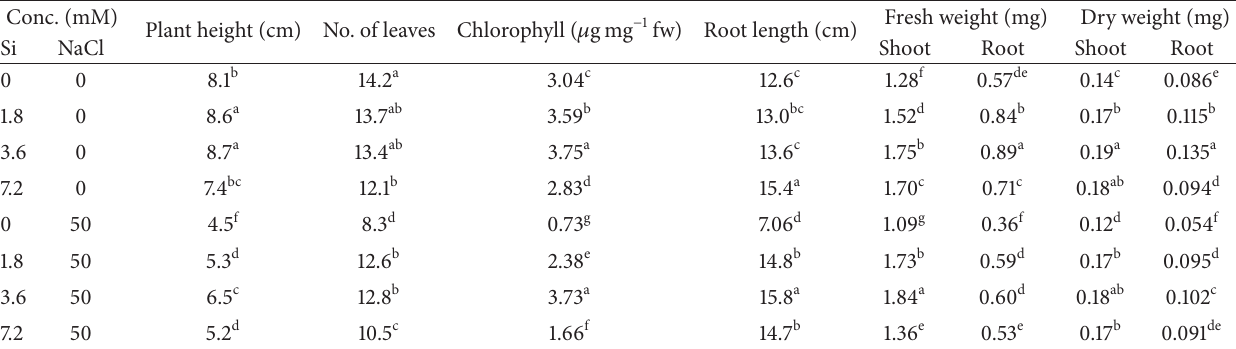
Table 3: Effect of Si and NaCl on growth characteristics of A. multiflora . Conc.